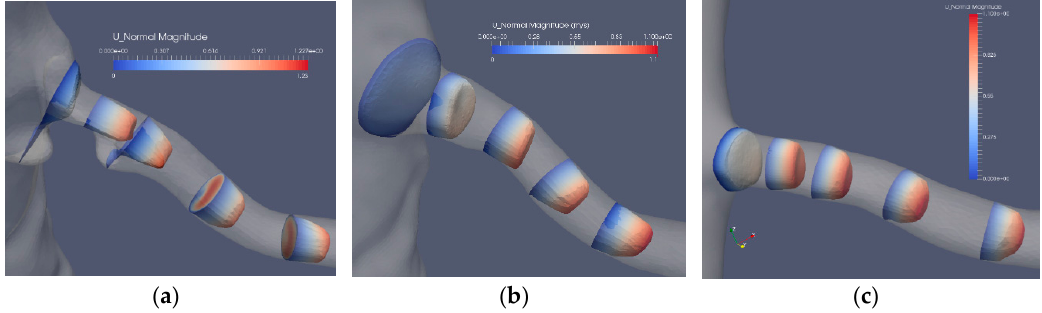
Figure 6. The axial and in-plane velocity components: stenosis (Case1.1) ( a ), Voronoi reconstructed (Case1.2) ( b ) and reconstructed with mesh sweeps (Case1.3) ( c ). Note that the scales of the axial components differ from the in-plane components.